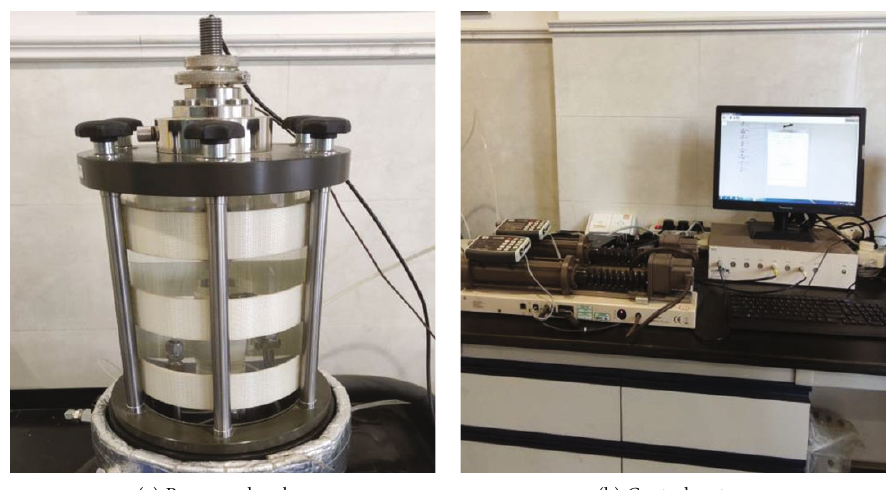
Figure 3: Triaxial test